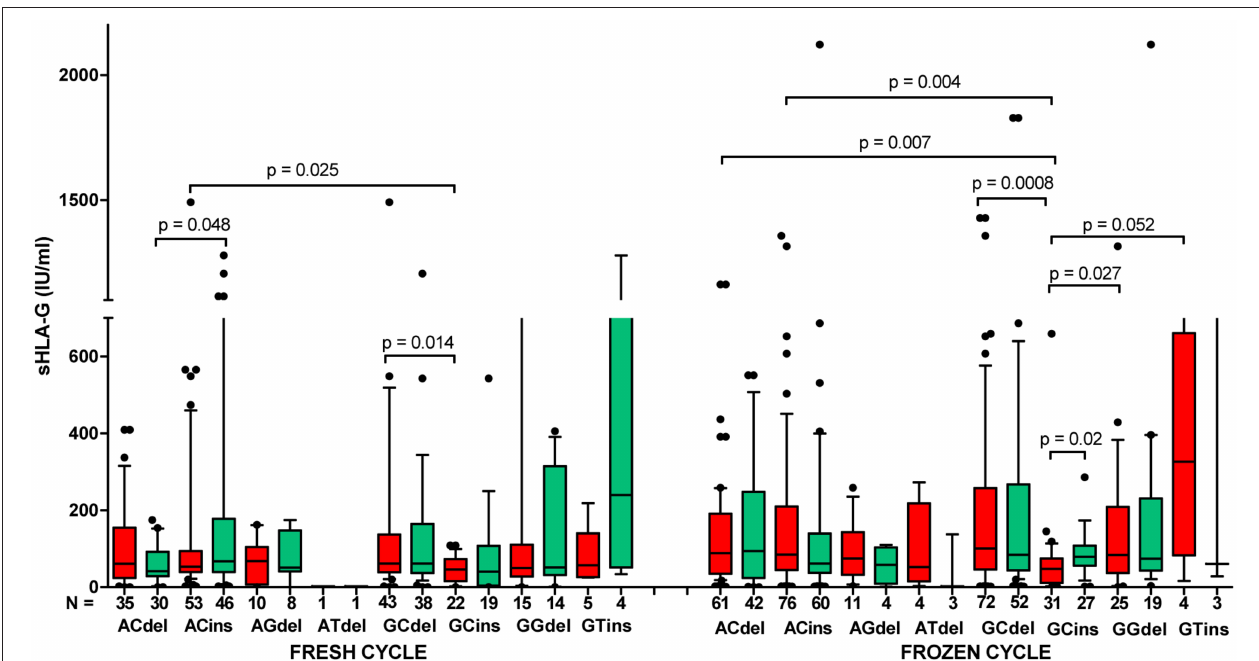
FIGURE 7 | Concentration of soluble HLA-G per milliliter of plasma (IU/ml) in all patients according to their HLA-G haplotypes, dependent on fresh or frozen/thawed cycle. Haplotypes were estimated in the following order: rs1632947: − 964G > A; rs1233334: − 725G > C/T; rs371194629:insATTTGTTCATGCCT/del. Boxes are drawn from the first quartile (25th percentile) to the third quartile (75th percentile). Black lines in boxes are medians. Whiskers represent 10–90 percentiles. N is the number of patients. sHLA-G was measured in plasma of patients before (red boxes) and after embryo transfer (green boxes). p -values are calculated by Mann–Whitney test. Comparison of haplotypes G C del and G C ins (fresh vs. frozen cycle) by Kruskal–Wallis test, p =